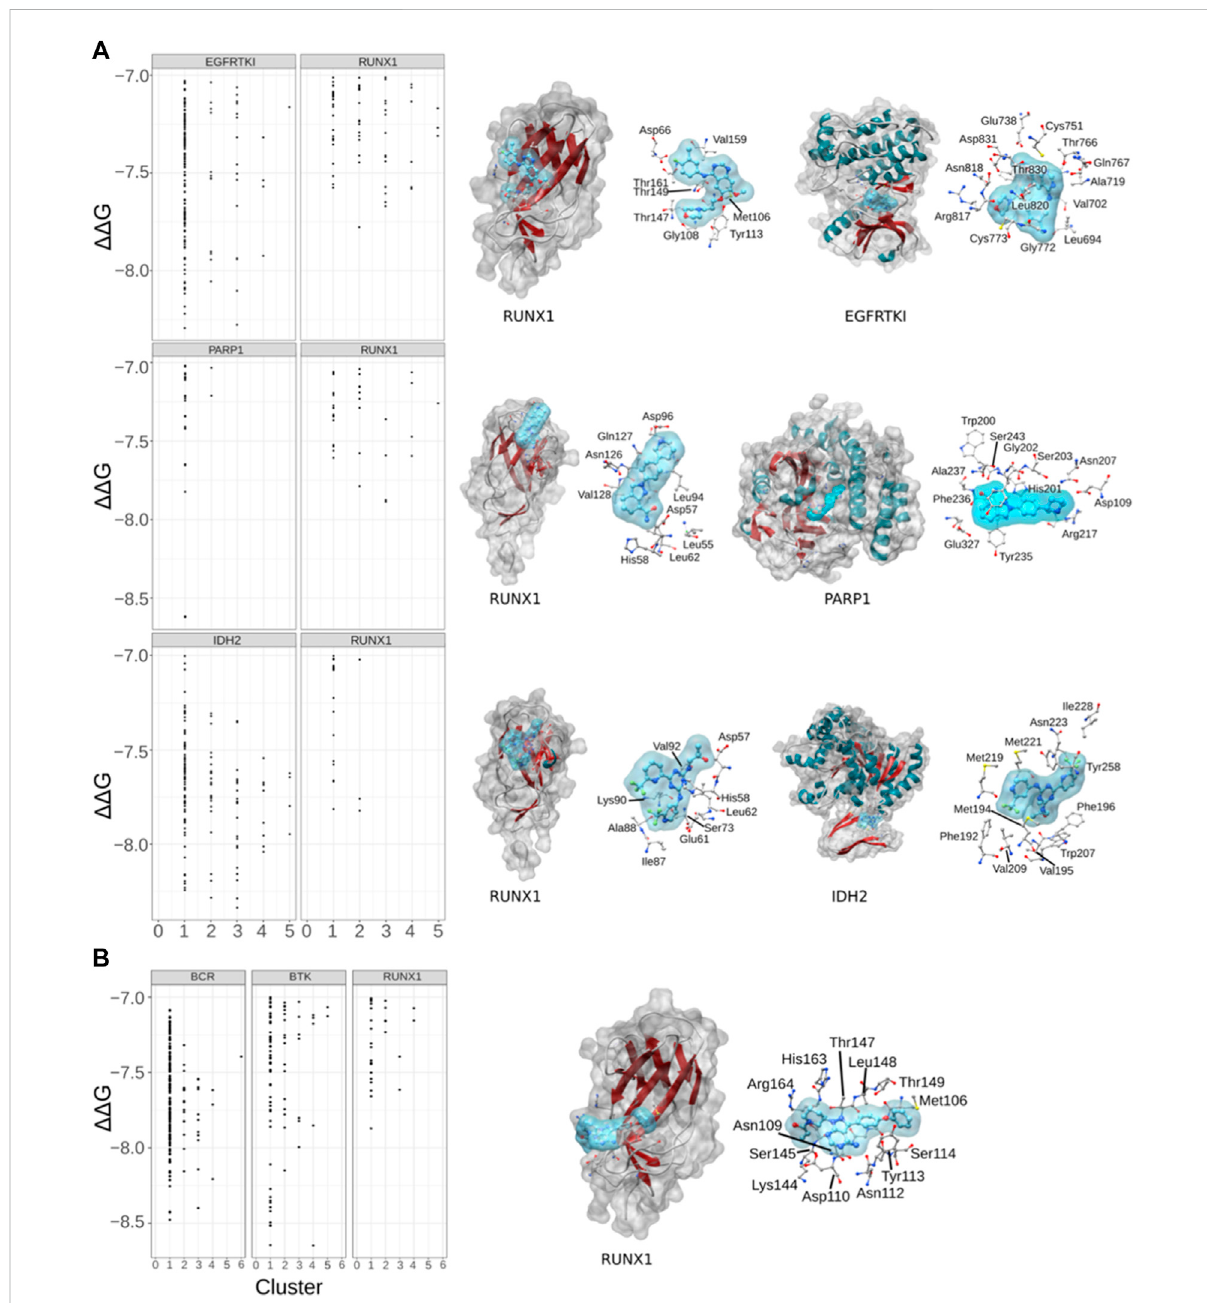
FIGURE 4 Drug associated targets and drug modeled binding with RUNX1. (A) Dot plots showing the comparative binding energy ( ΔΔ G) for ge fi tinib (lung cancer),niraparib(ovariancancer),andenasidenib(AML). Shownisthepredictedge fi tinibbindingsiteversustheknownbindingareaofge fi tinibwith its target protein EGFRTKI. Similarly, comparisons are shown with niraparib with its known protein target PARP1, and enasidinib and its established target IDH2. (B) Ibrutinib with its accepted targets BCR and BTK, versus that predicted with